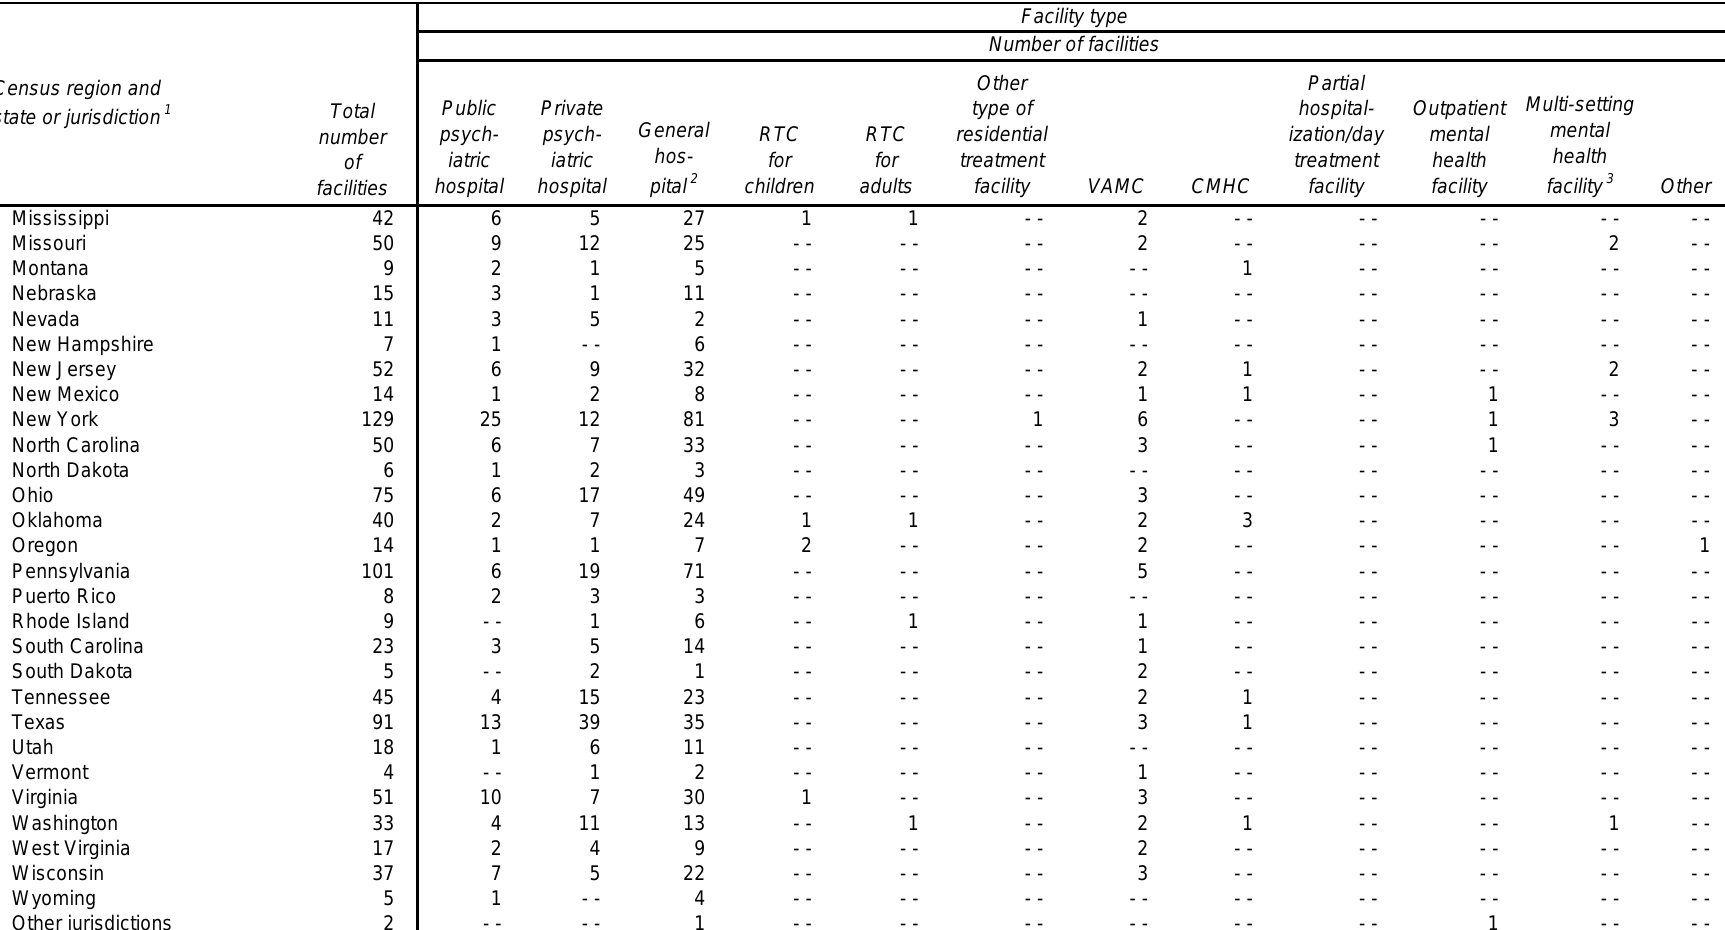
Table 3.3a. Mental health treatment facilities providing 24-hour hospital inpatient treatment, by facility type, Census region, and state or